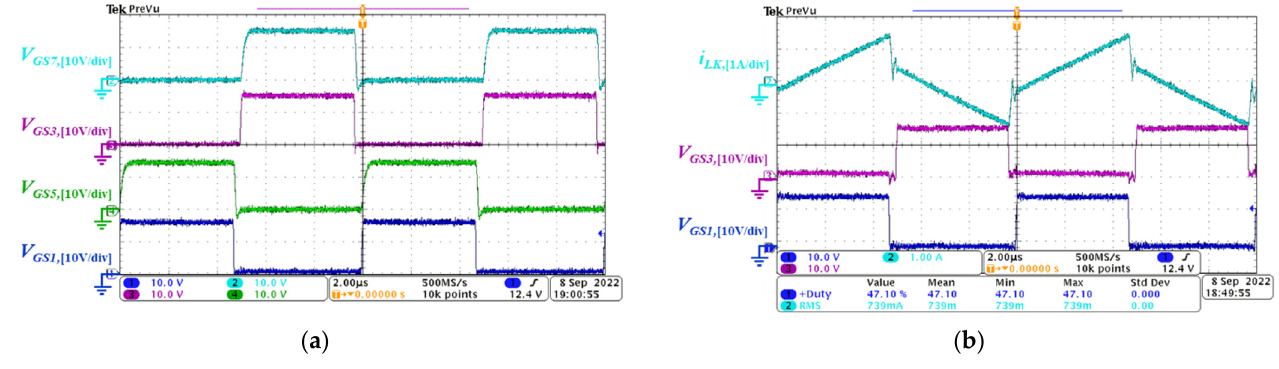
Figure 13. Experimental waveforms of the prototype converter operating in forward power conver- sion mode (at 200 W output power): ( a ) waveforms of gate signals V GS1 , V GS3 , V GS5 and V GS7 ; ( b ) wave- forms of gate signals V GS1 , V GS3 , and inductor current i LK .